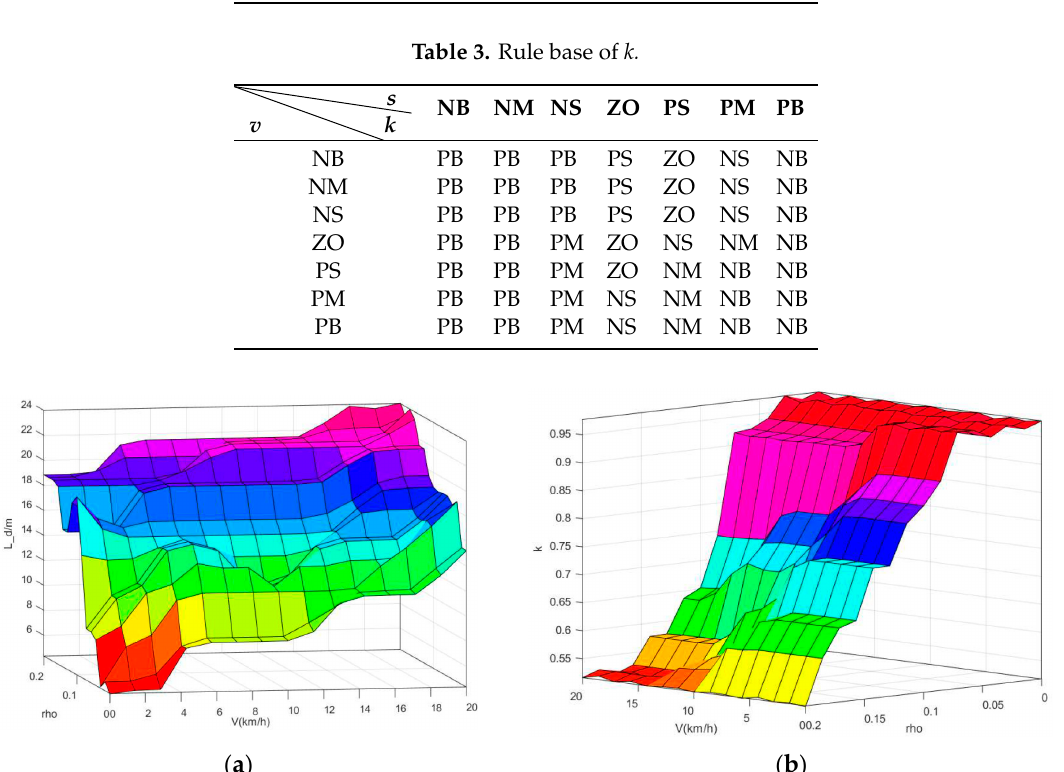
l . ( b ) The surface of k . Figure 10. The surface of outputs. ( a ) The surface of l (cid:48) d . ( b ) The surface of k d